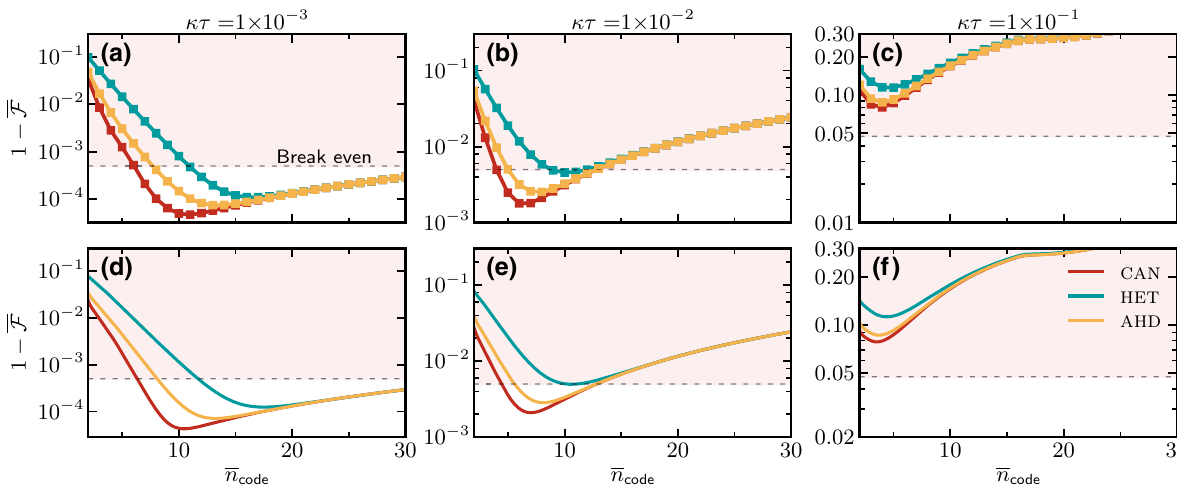
FIG. 6. Average gate infidelity for order N = 2 bin (top) and cat (bottom) codes as a function of the average code photon number n code for different phase measurement schemes. The results are obtained by simulating the telecorrection circuit in Fig. 3 with equal loss and dephasing strength κτ = κ φ τ . Columns show results for different amounts of noise κτ before error correction is performed. Error correction is beneficial whenever the infidelity falls below the dashed line that indicates the break-even point, that is, the performance of the trivial Fock encoding without error correction. Note the different scaling of the y axis through the columns with different κτ .